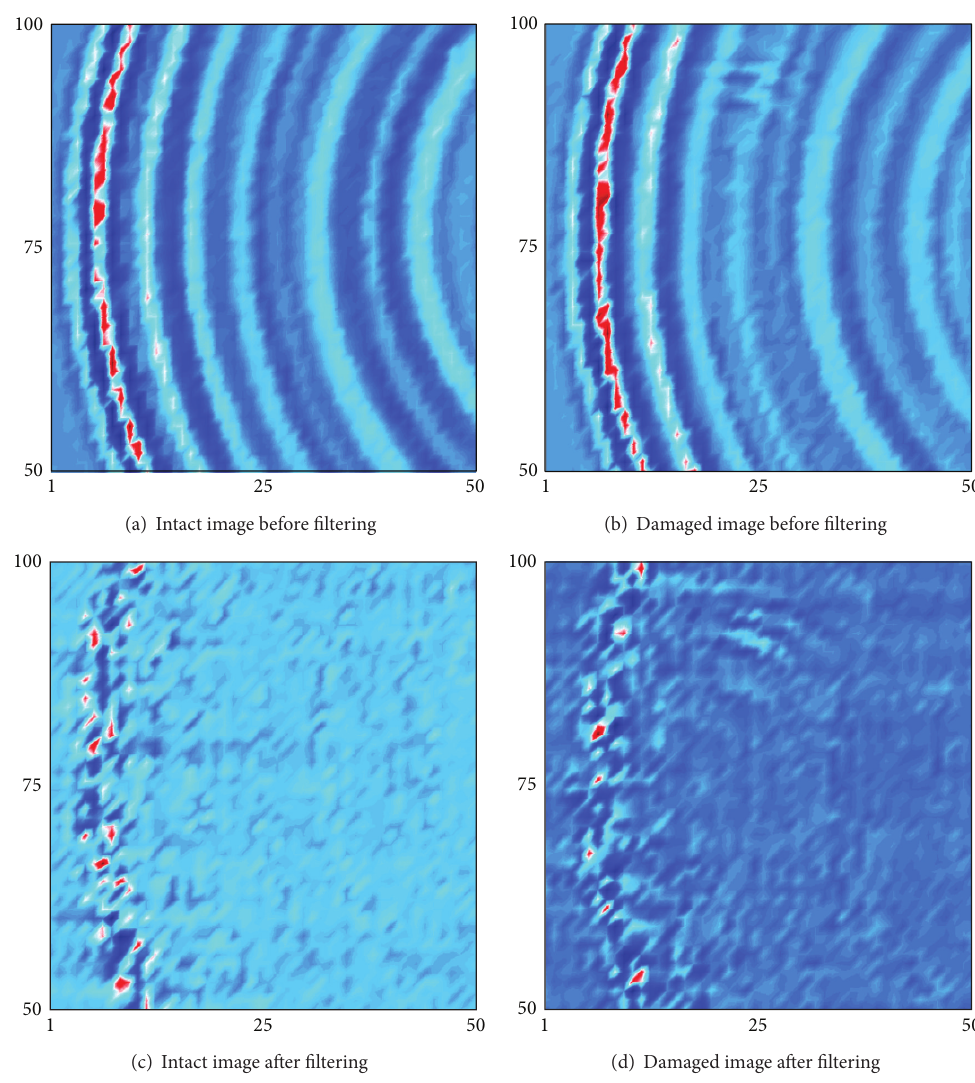
Figure 15: Comparison of UWPI snapshots at 46 𝜇 s for damage case